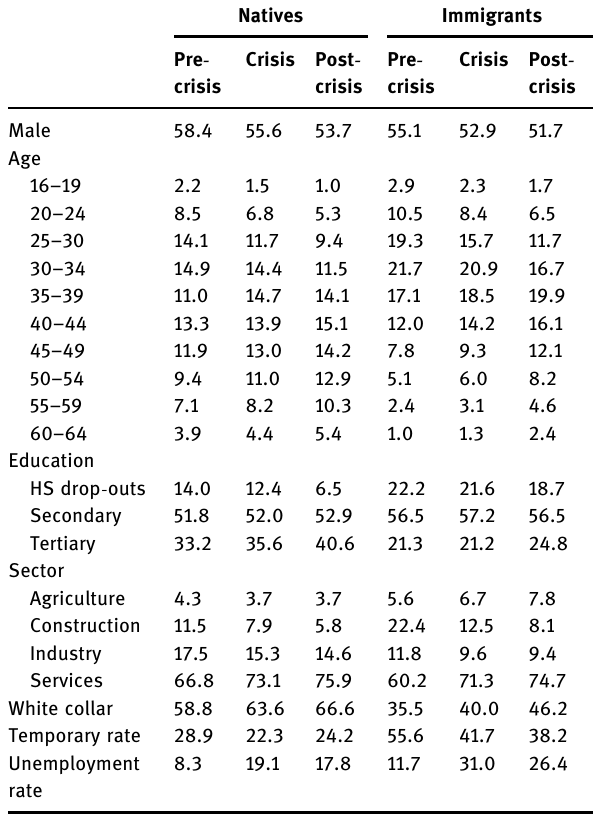
Table 1: Immigrants and natives characteristics